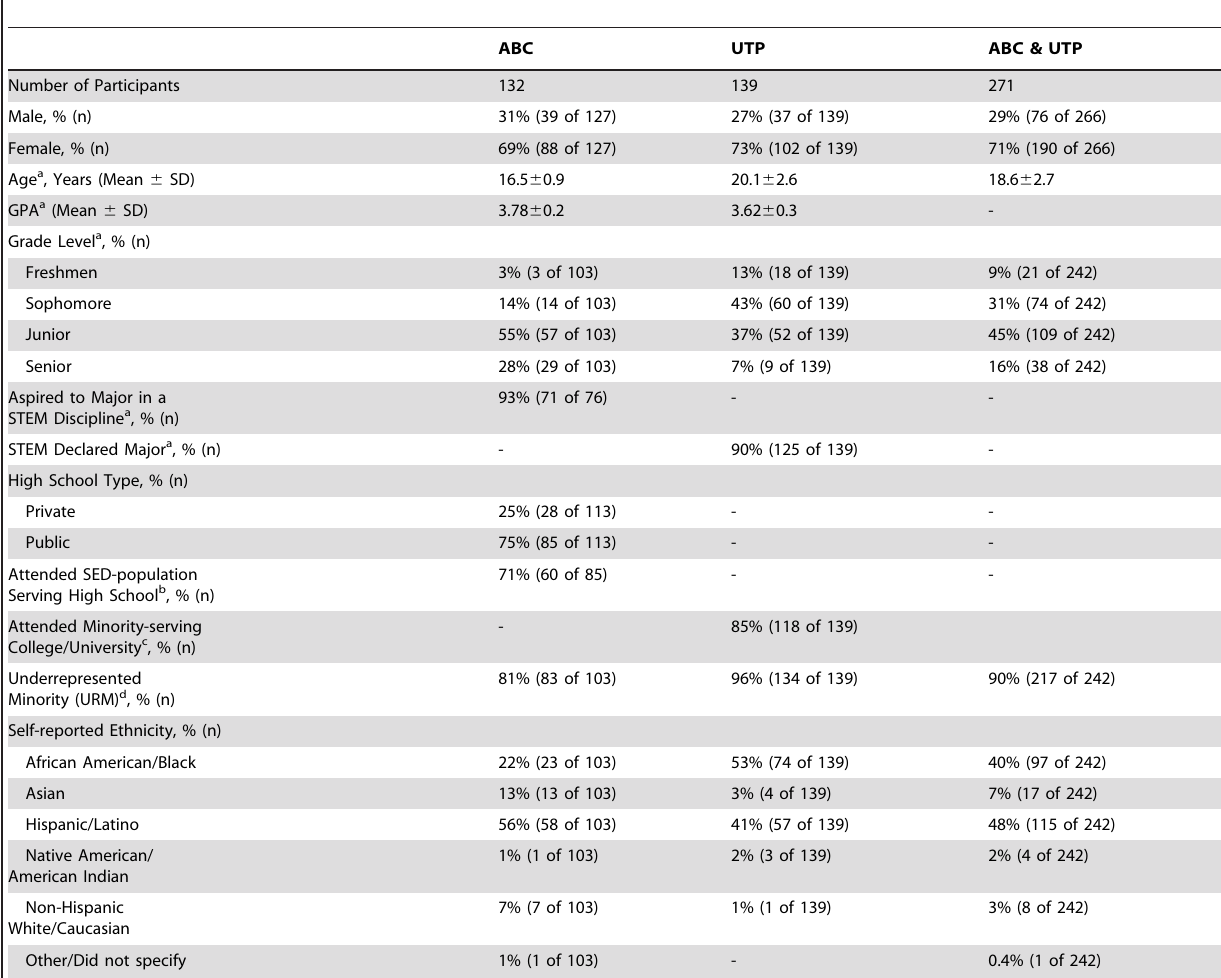
Table 1. Participant Demographic Characteristics at the Time of the Summer Research Experience, ABC (1997–1999, 2001–2012)